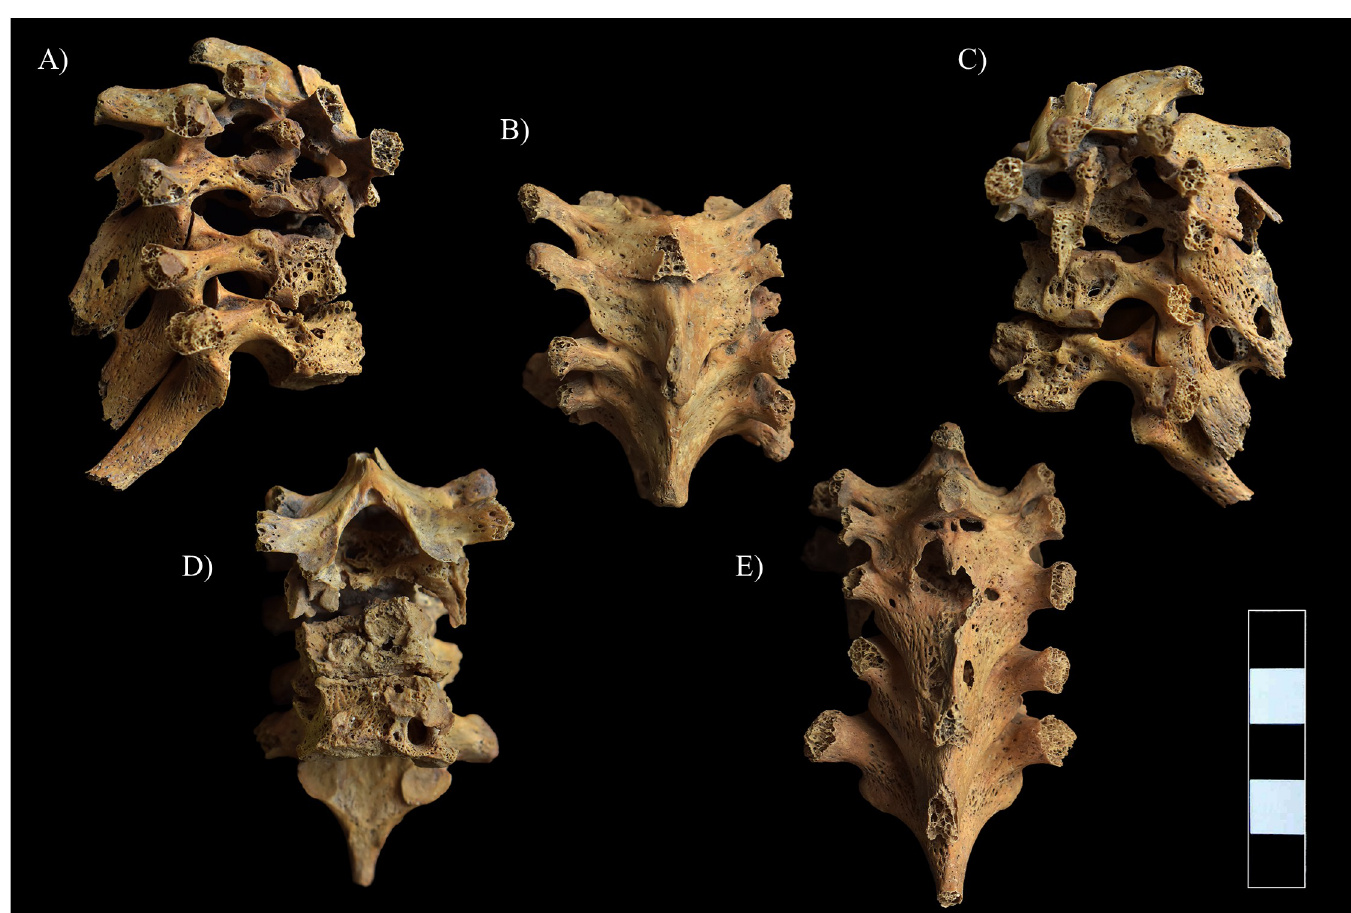
Fig 7. Pott’s gibbus in the T1–7 region. A) Lateral view (right side), B) Superior view, C) Lateral view (left side), D) Anterior view, and E) Posterior